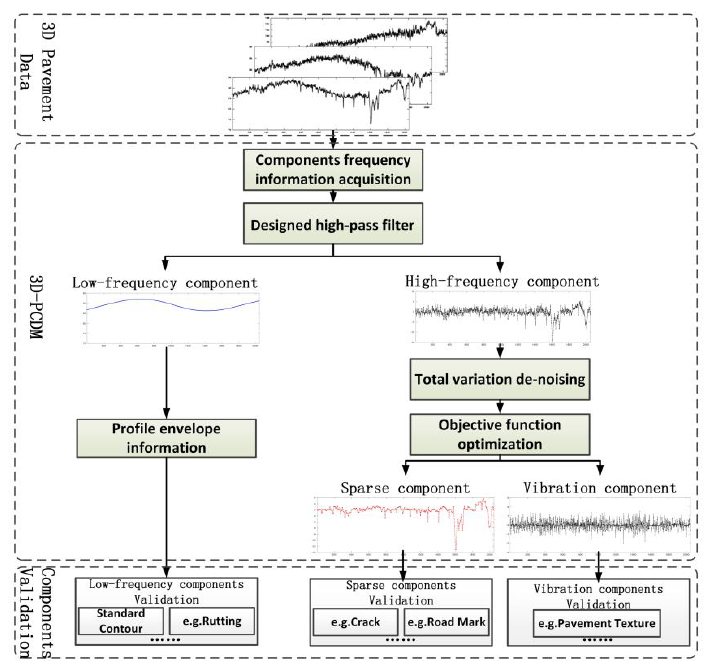
Figure 6. Flowchart of the proposed 3D-PCDM.